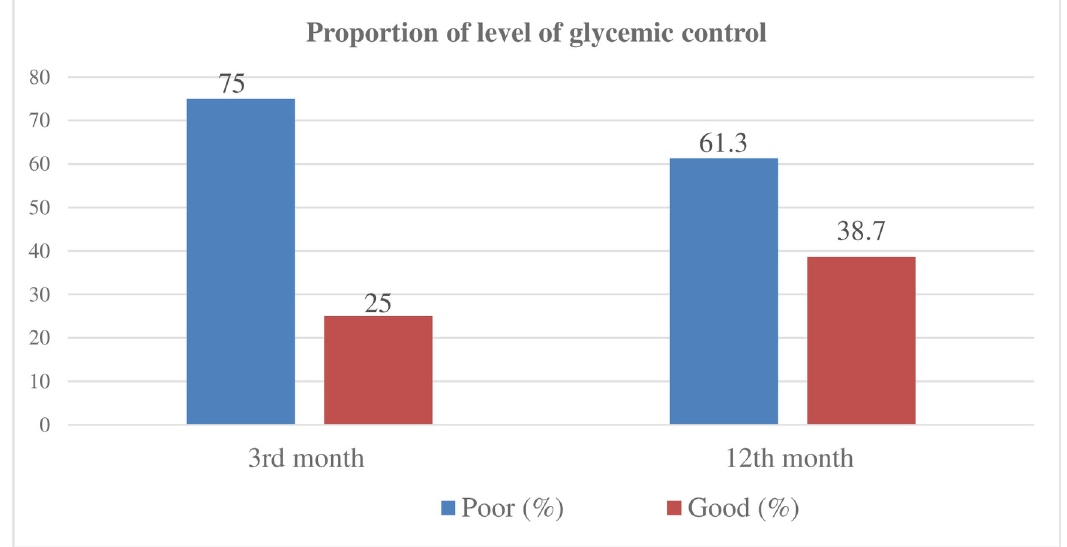
Fig 1. Proportion of participants to level of glycemic control after insulin initiation (N = 424).